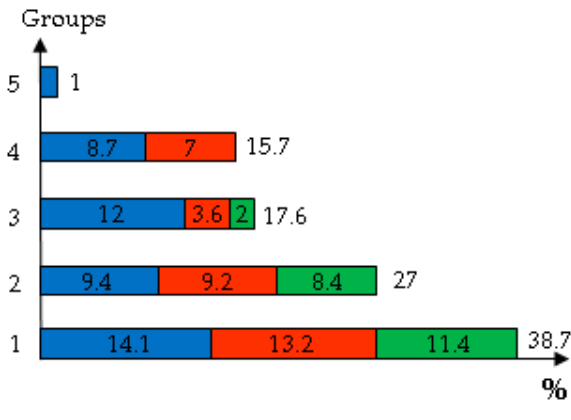
Figure 1. Thematic groups for the associative verbal field “the Arctic”.